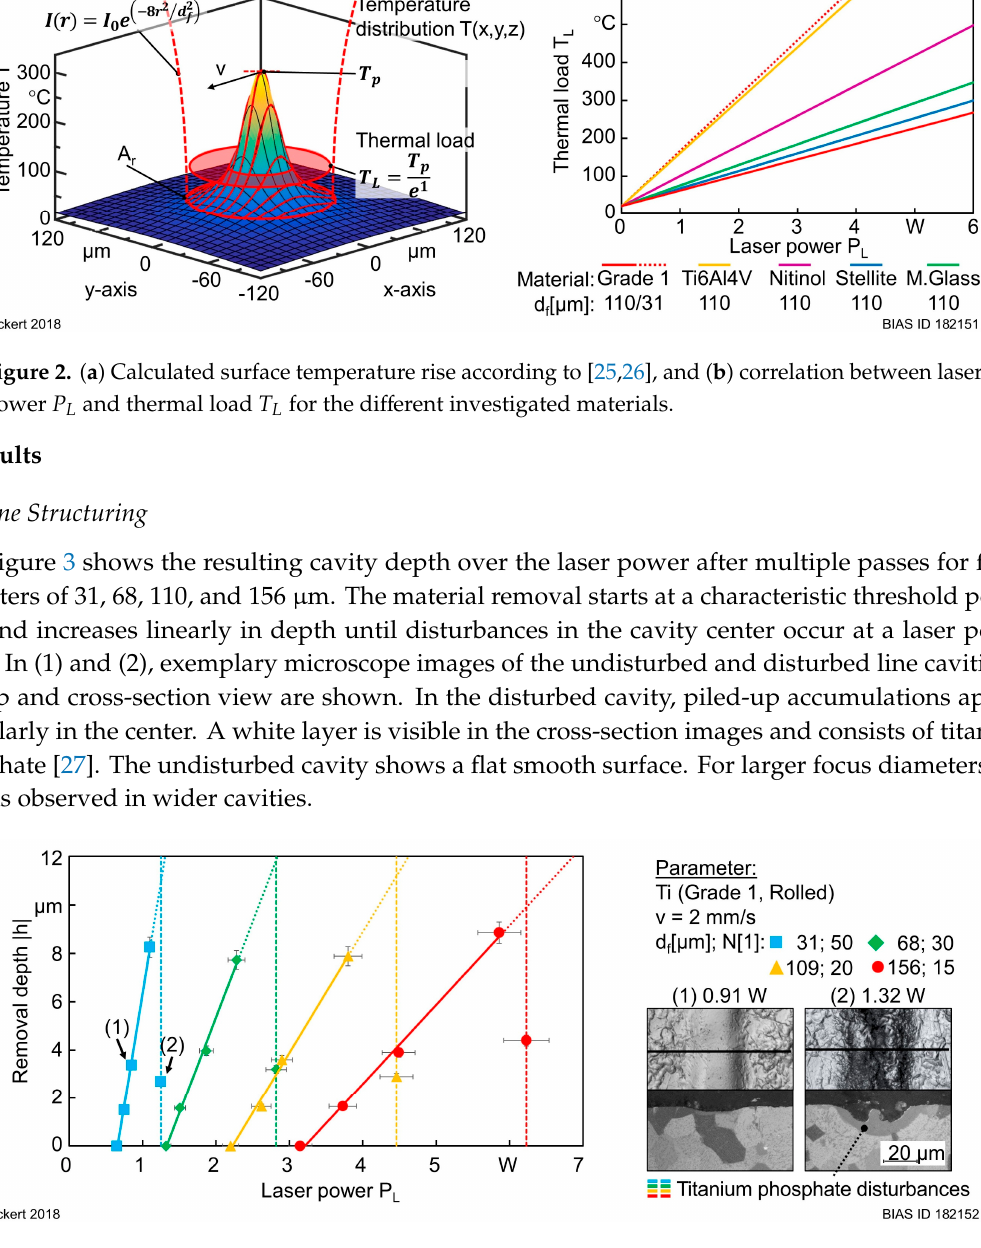
Figure 3. Removal depth over laser power for different focus diameter.